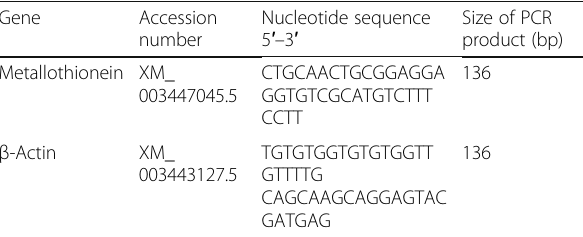
Table 1 Name, accession number, primer sequence, and product size for genes used for real-time PCR analysis Gene